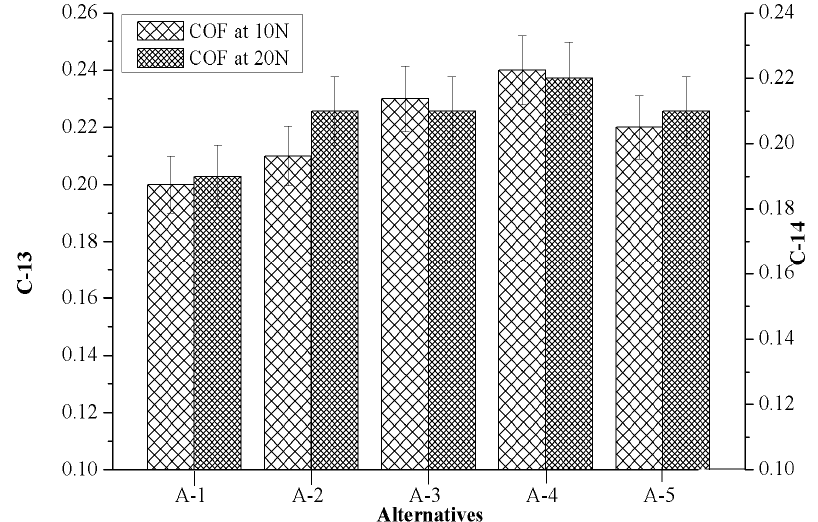
Figure 9. Evolution of criterion-13 together with criterion-14 in respect to the values of alternatives.